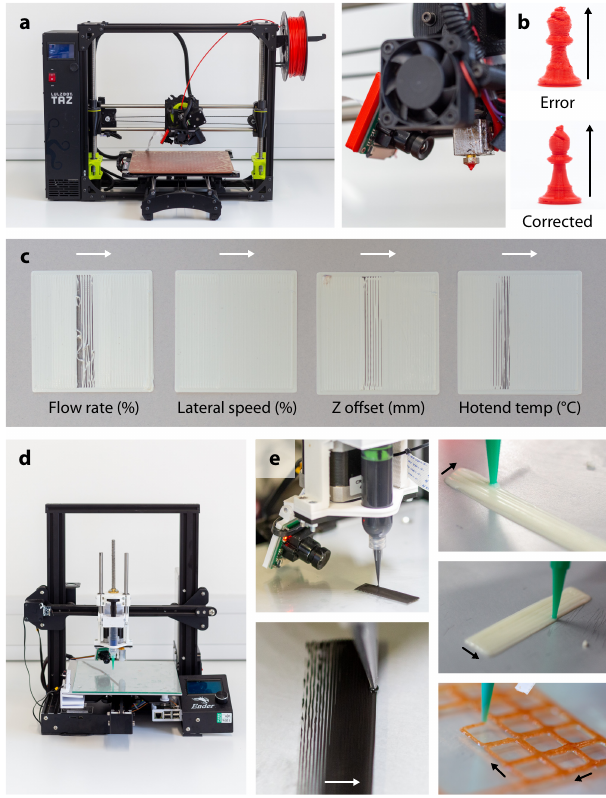
Fig.5|Approachgeneralisesacrosssetupsandextrusionprocesses.a Photosof a tested unseen 3D printer with a 0.6mm inner diameter nozzle (Lulzbot Taz 6). A different cameramodel (Raspberry PiCamerav1) and lens were used compared to the collection of training data along with a new camera position with respect to materialdeposition. b Abishopchesspiecewitherroneousparametersintroduced and the same erroneous print with correction enabled. Both were printed using 2.85mm PLA on the unseen Lulzbot Taz 6 setup. c Rapid correction of a manually induced erroneous single parameter using the trained multi-head neural network. Printed with white PLA feedstock on an unseen printer with an unseen 0.6mm nozzlenotusedintrainingdata. d Syringe-basedprinterfordirectinkwriting(DIW) modi fi ed from a Creality Ender 3 Pro. An unseen camera model (Raspberry Pi Camerav1)andlenswereusedalongwithadifferentcameraposition. e Automated correction and parameter discovery showed for PDMS with 0.21mm nozzle (27- gauge), alongside mayonnaise and ketchup with 0.84mm nozzle